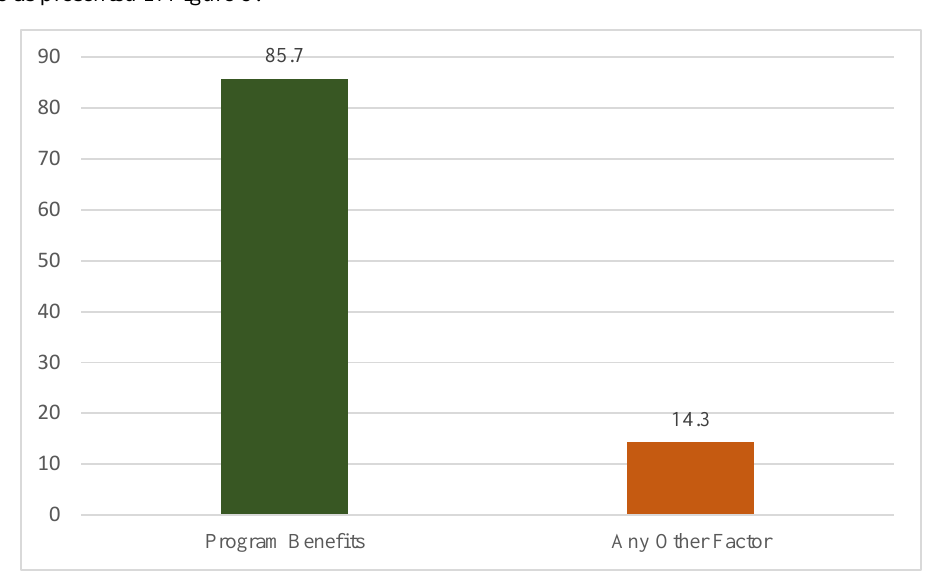
Figure 3: Institutional Determinants in Government Fully Funded Development